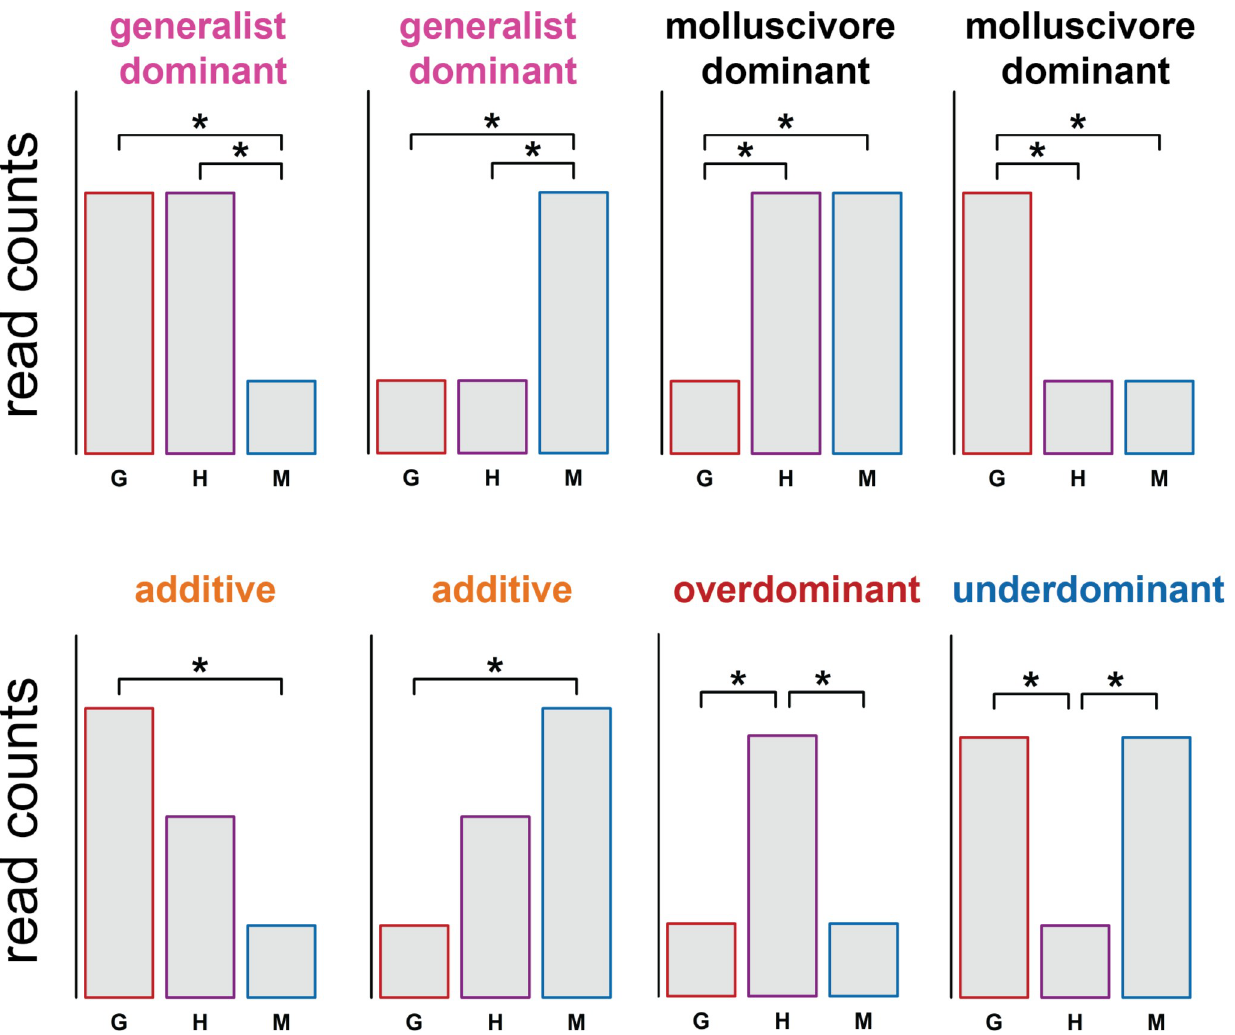
Fig 2. Classifying gene expression inheritance in hybrids. Schematic showing how gene expression inheritance in hybrids was classified. Asterisks indicate significant differential expression between groups. G = generalists, H = F1 hybrids, M = molluscivores.